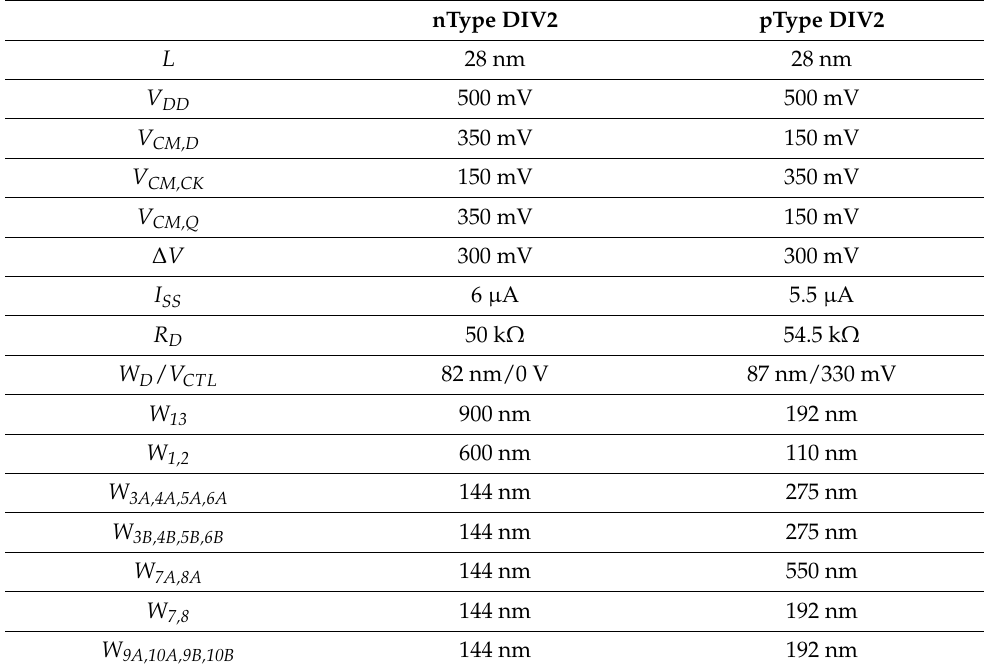
Table 3. Design parameters for the DIV2 with FBB at minimum PDP.